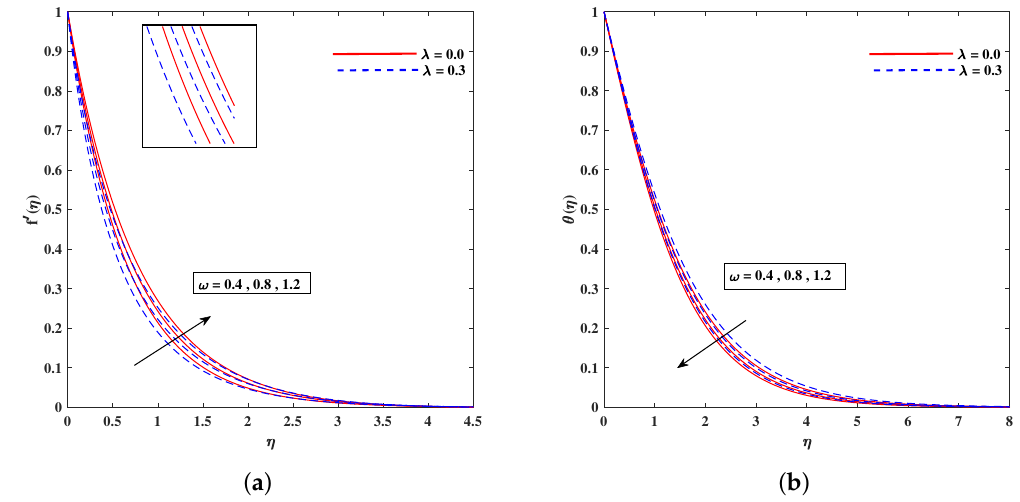
Figure 4. Fluctuation of ω on velocity f (cid:48) ( η ) ( a ) and temperature profile θ ( η ) ( b